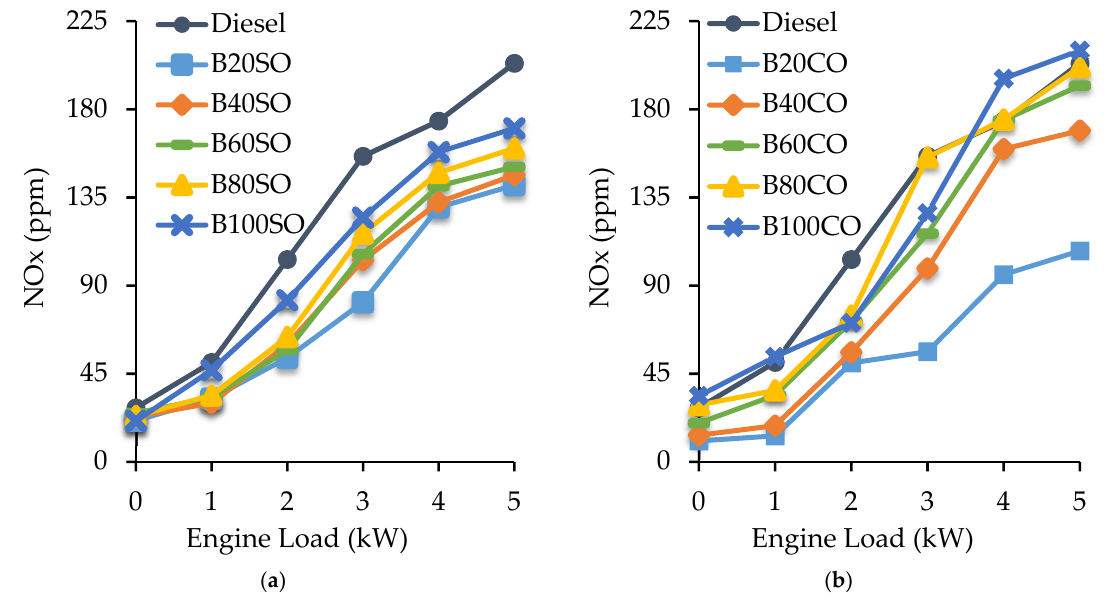
Figure 8. Nitrogen oxides (NO x ) emissions (in ppm) generated under different engine operating powers (from 0 to 5 kW), depending on the triple blends: ( a ) Diesel/ABE/sunflower oil and ( b ) Diesel/ABE/castor oil.